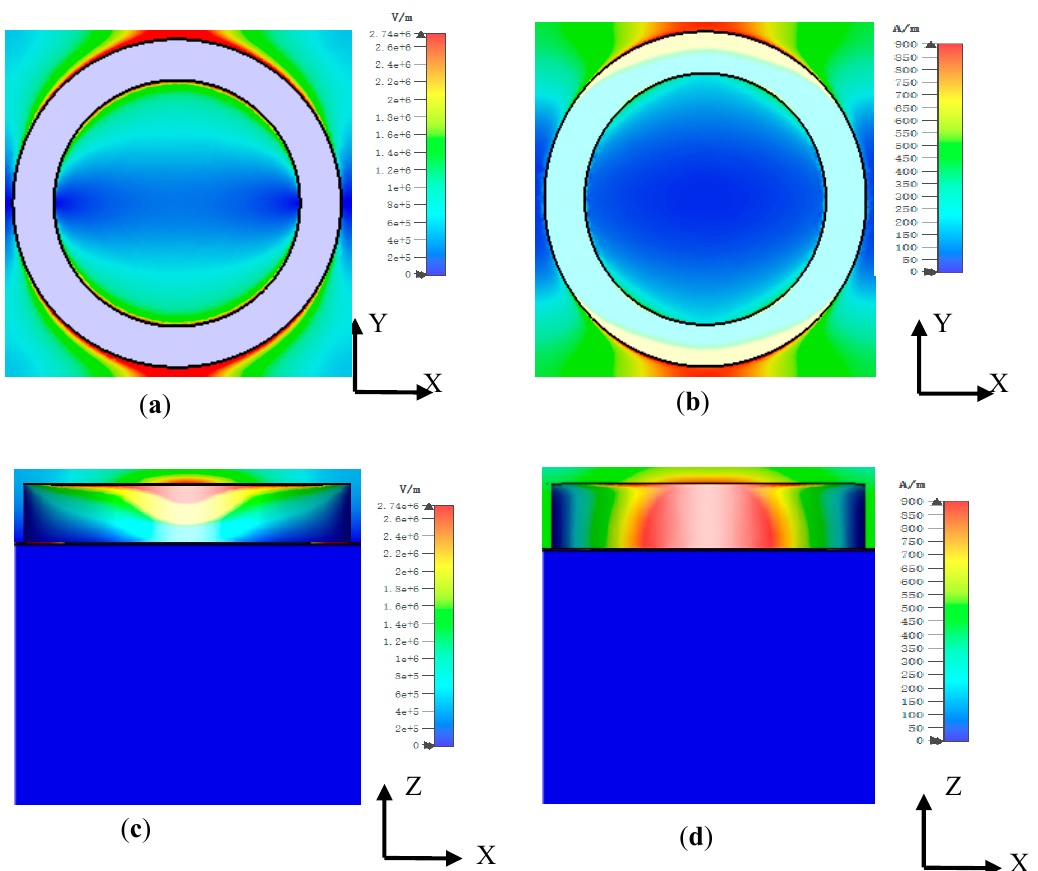
Figure 2. The electric field distribution of the stainless steel absorber at the x-y cross-section of the unit cell ( a ) and at the x-z cross-section of the unit cell ( c ) at 1.563 THz. The magnetic field distribution of the stainless steel absorber at the x-y cross-section of the unit cell ( b ) and at the x-z cross-section of the unit cell ( d ) at 1.563 THz.